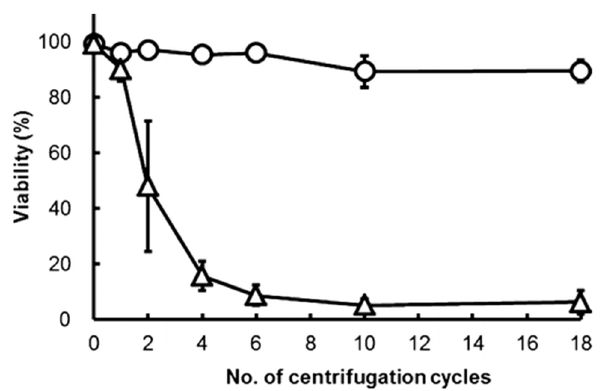
Figure 14. Cell viability after centrifugation for human hepatocyte carcinoma cells with ( ○ ) and without ( Δ ) fibronectin–gelatin containing nine layers. Reprinted with permission from reference [315]. Copyright (2013), with permission from American Chemical Society.